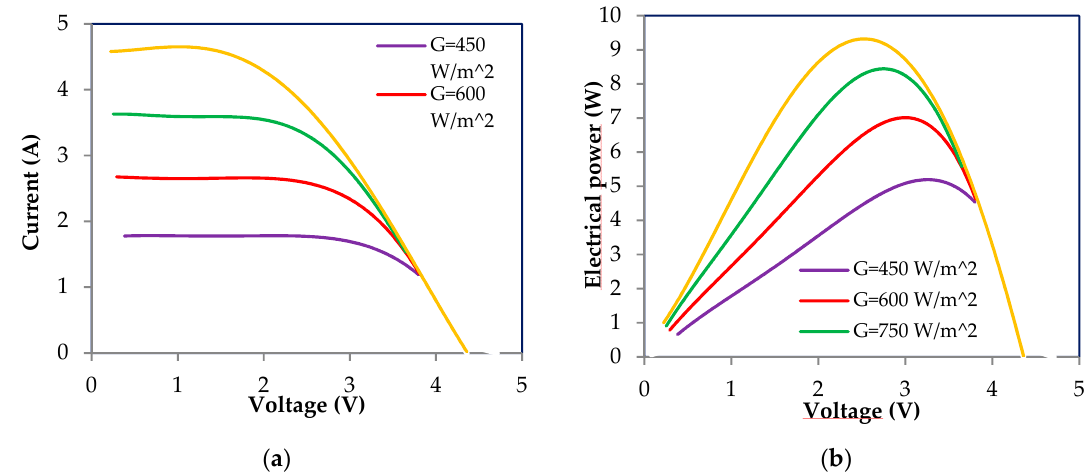
Figure 5. Characteristics of the noncooled PV roof tile: ( a ) current voltage; and ( b ) electrical power voltage.